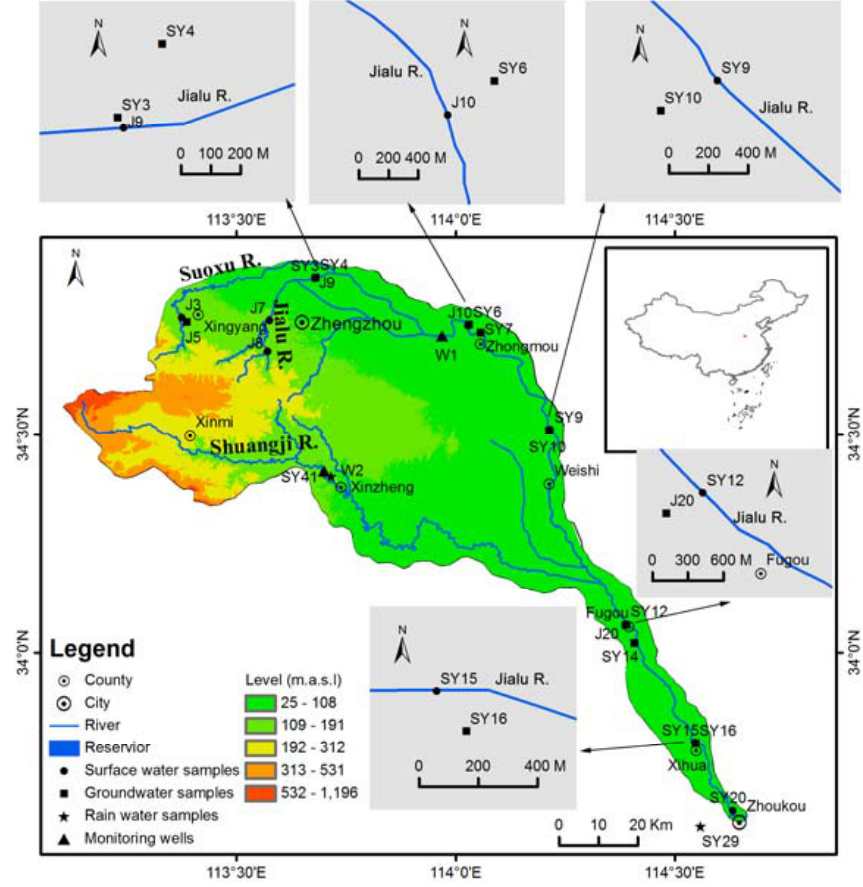
Fig. 1. Study area and relevant sampling